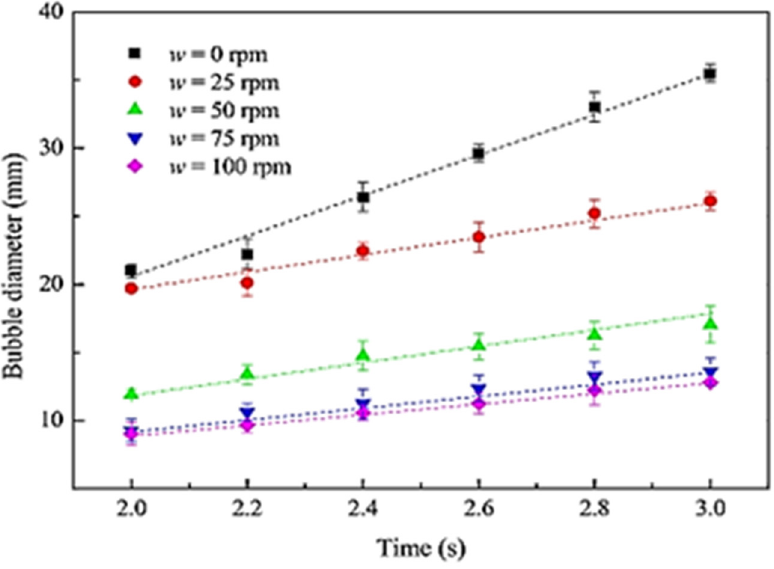
Figure 19. Graph of variation of bubble diameter with agitation speed [151].